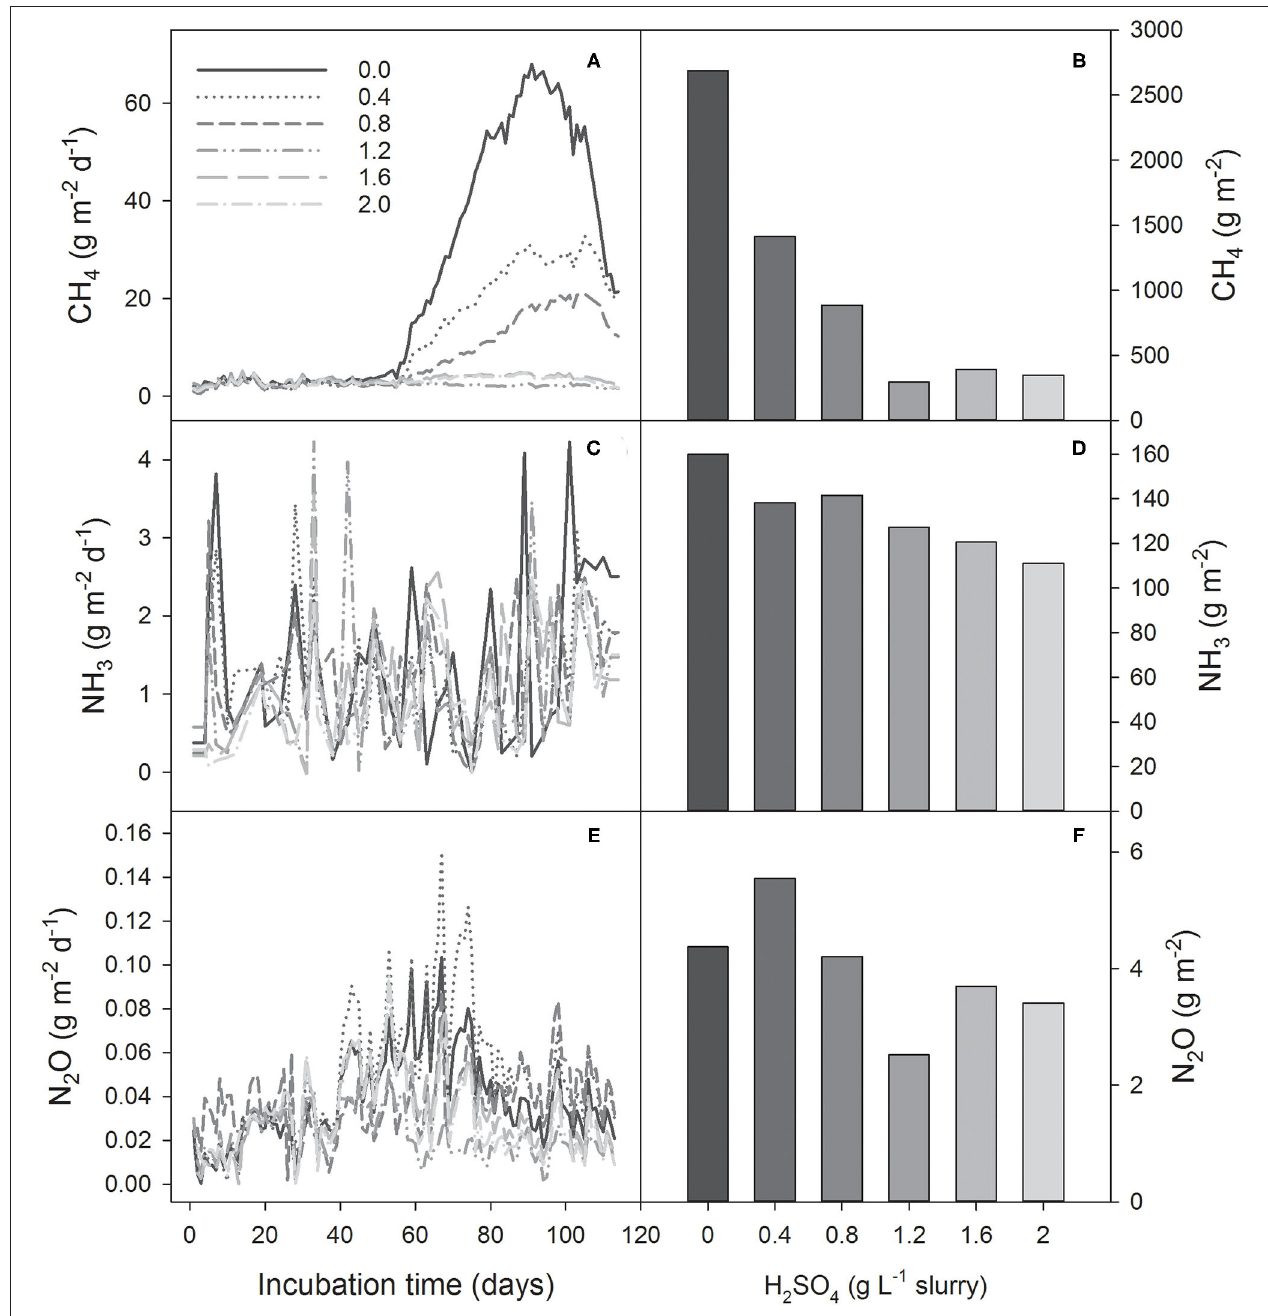
FIGURE 3 | Gases emitted from acidified (0.4–2.0g H 2 SO 4 L − 1 slurry) and control (untreated) dairy slurries, shown by daily flux of [ (A) CH 4 , (C) NH 3 , (E) N 2 O] and total cumulative emissions [ (B) CH 4 , (D) NH 3 , (F) N 2 O] for the entire storage period (114 d; May 25–September 15, 2019).